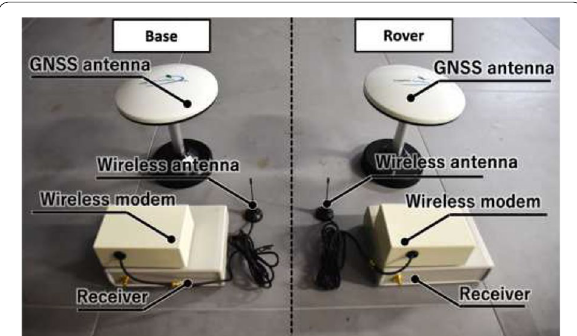
Fig. 3 Real-time kinematic GPS module (MJ-2001-GL1, Magellan Systems Japan Inc.)